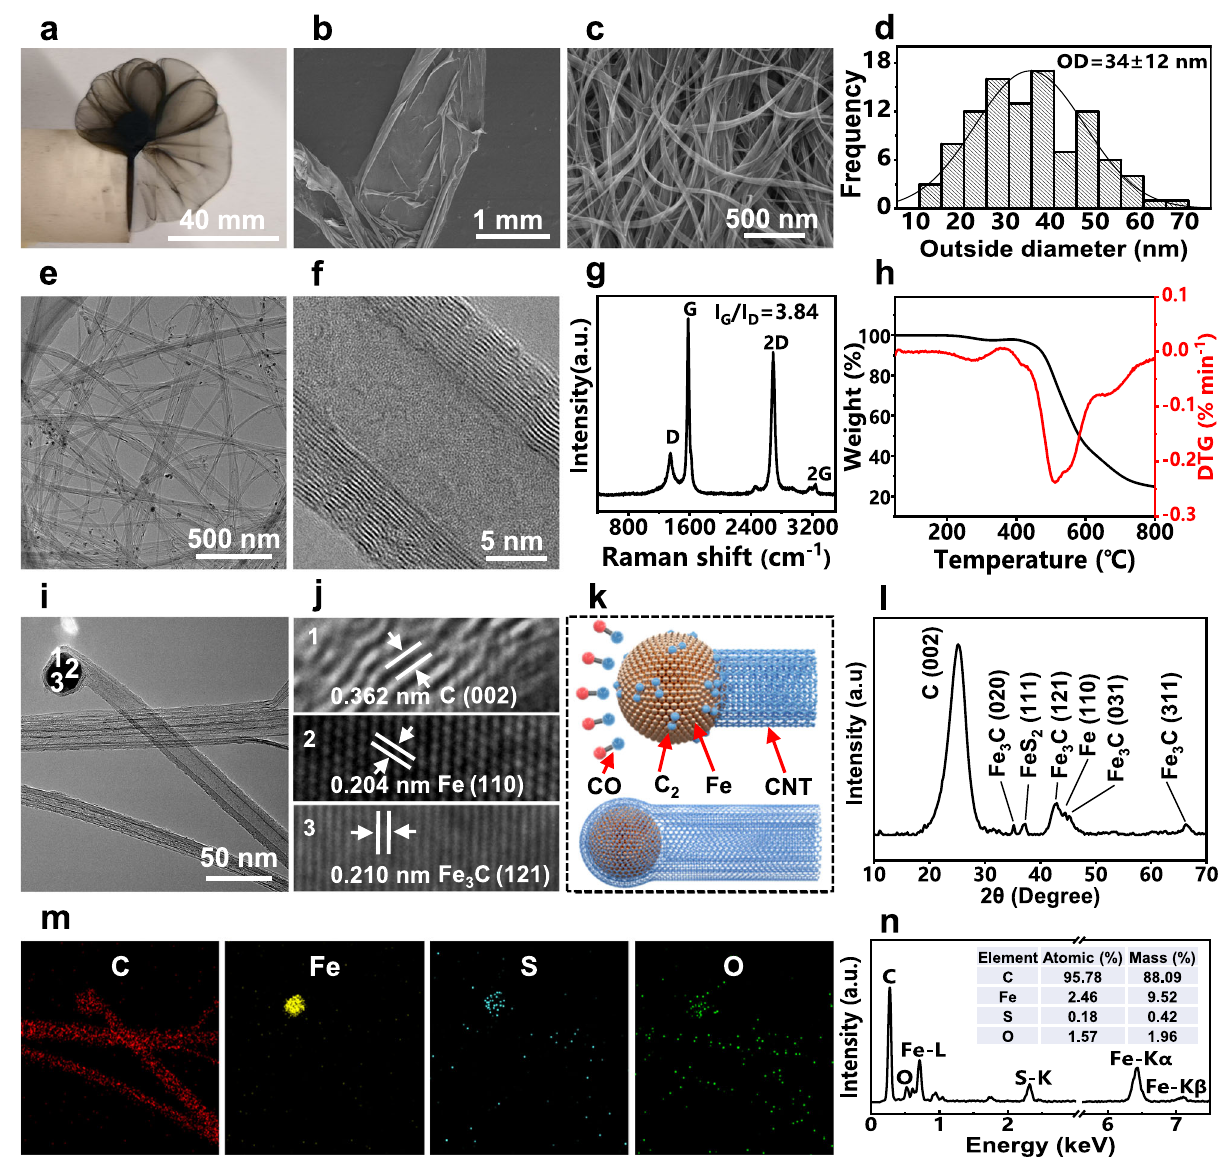
Fig. 3 | Synthesis and structures of the lignin-derived CNTs. a Digital image and b SEM image of a CNTsock. c SEMimage and d diameter distribution ofthe CNTs. e,f TEM images of the CNTs. g Ramanspectrum and h thermogravimetric analysis (TGA)of the CNTs. i TEM imageof the CNTsand catalyst particles. j Lattices of